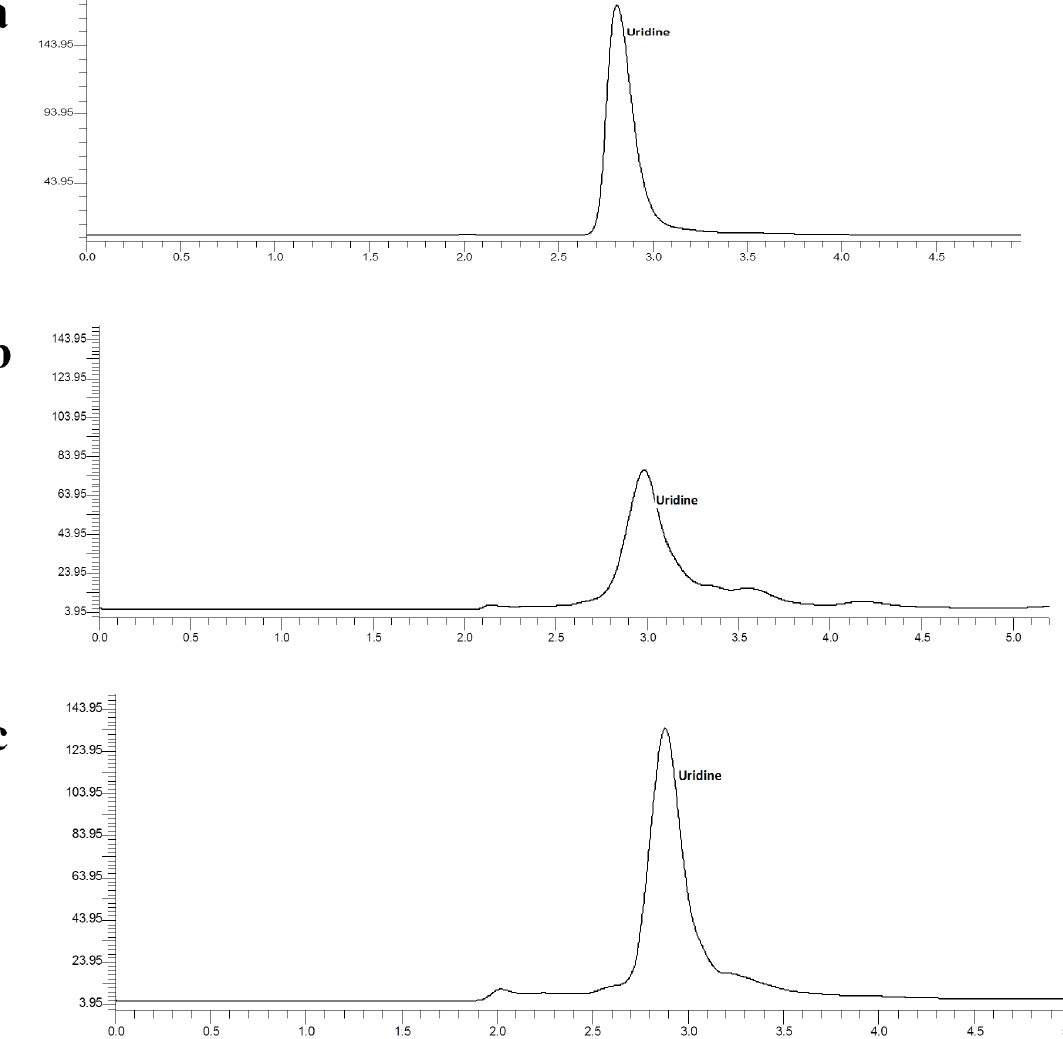
Fig 3. HPLC chromatogram of (a) uridine reference (Lot no.:#030M1518V), (b) ethanol extract of P . giganteus , and (c) aqueous extract of P . giganteus .